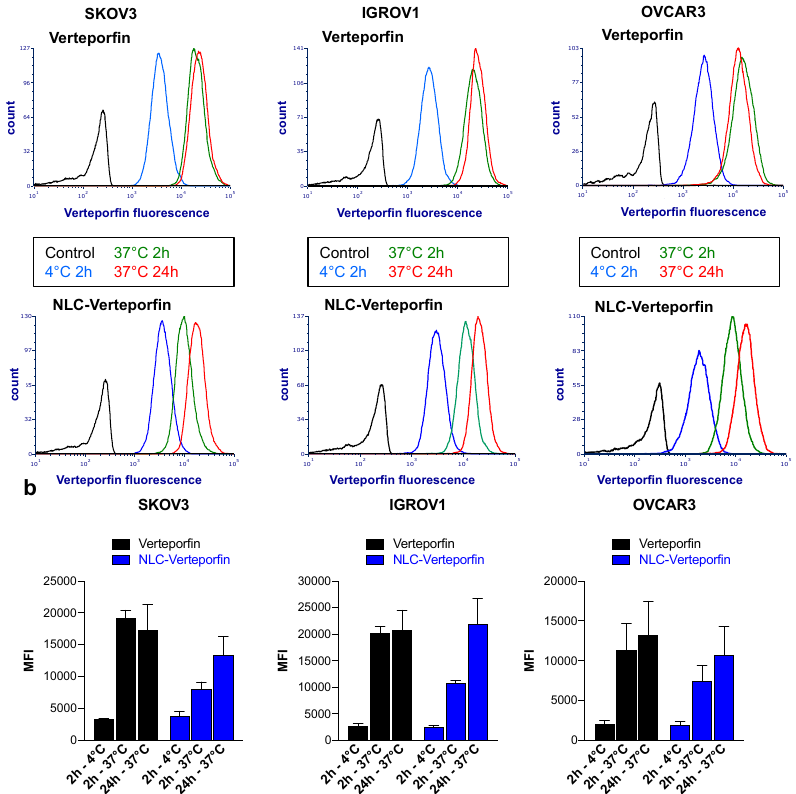
Figure 1. Verteporfin and NLC-verteporfin interact with ovarian cancer cells. Ovarian cancer SKOV3, IGROV1, and OVCAR3 cells were incubated with 1 µ mol · L − 1 verteporfin or NLC-verteporfin for 2 h or 24 h at 4 ◦ C or 37 ◦ C as indicated. ( a ) Histograms show cellular uptake assessed by flow cytometry. Black, control cells; blue, 4 ◦ C for 2 h; green, 37 ◦ C for 2 h; red, 37 ◦ C for 24 h. ( b ) Median fluorescence intensity (MFI). Data are expressed as the mean ± standard deviation (SD) of three independent experiments.